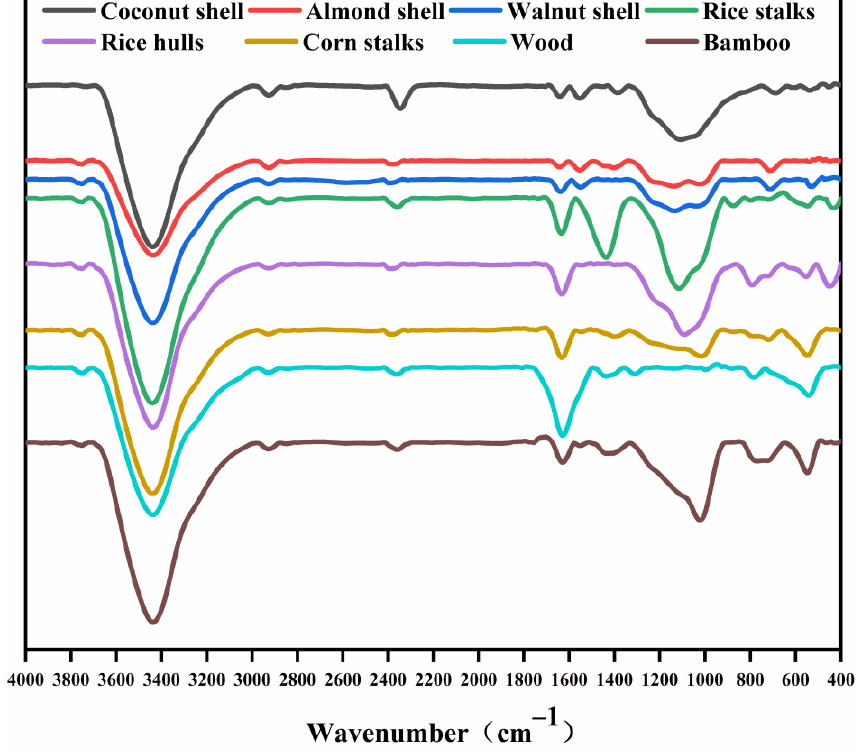
Figure 3. FTIR spectra of biochars.